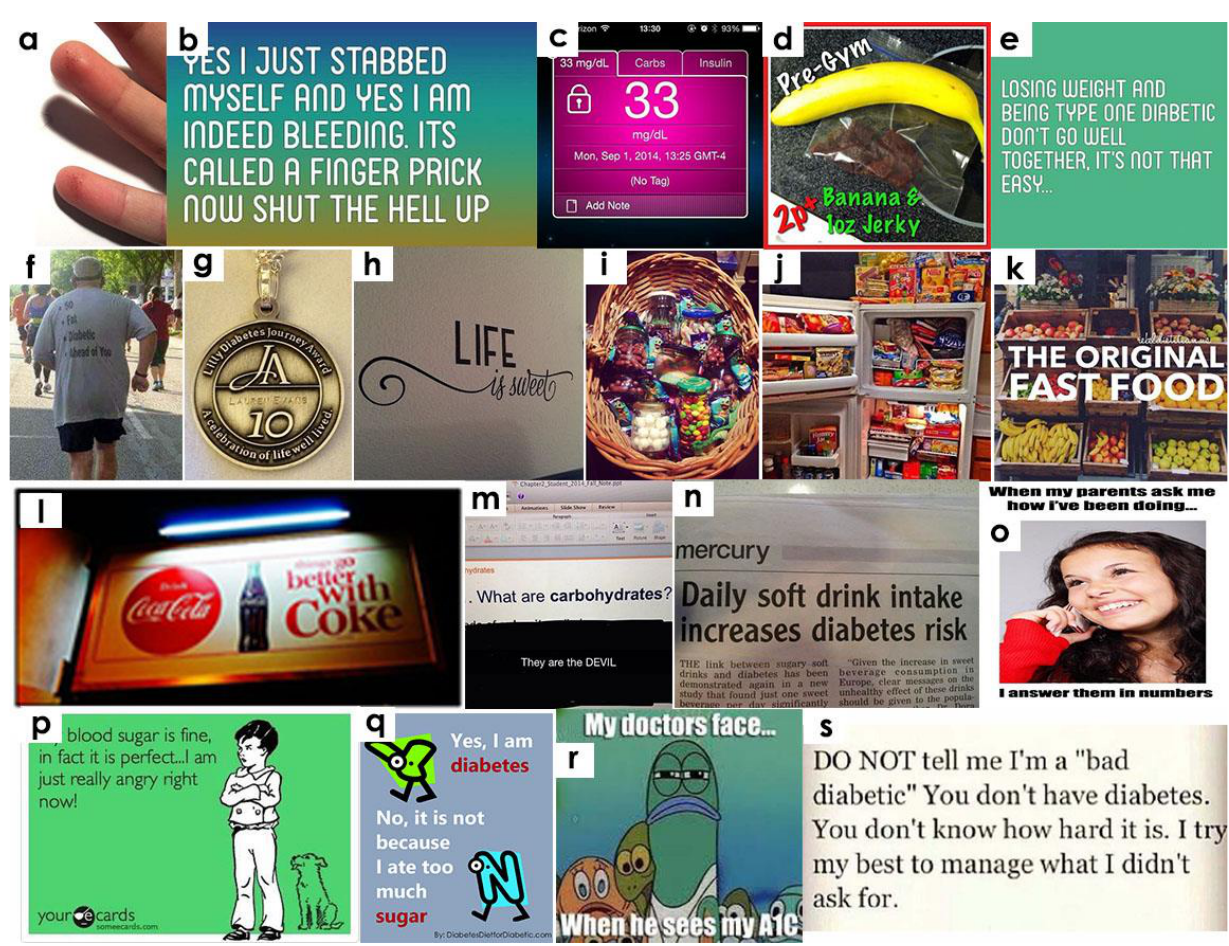
Figure 3. Images related to the maintenance of diabetes posted by Tumblr users.